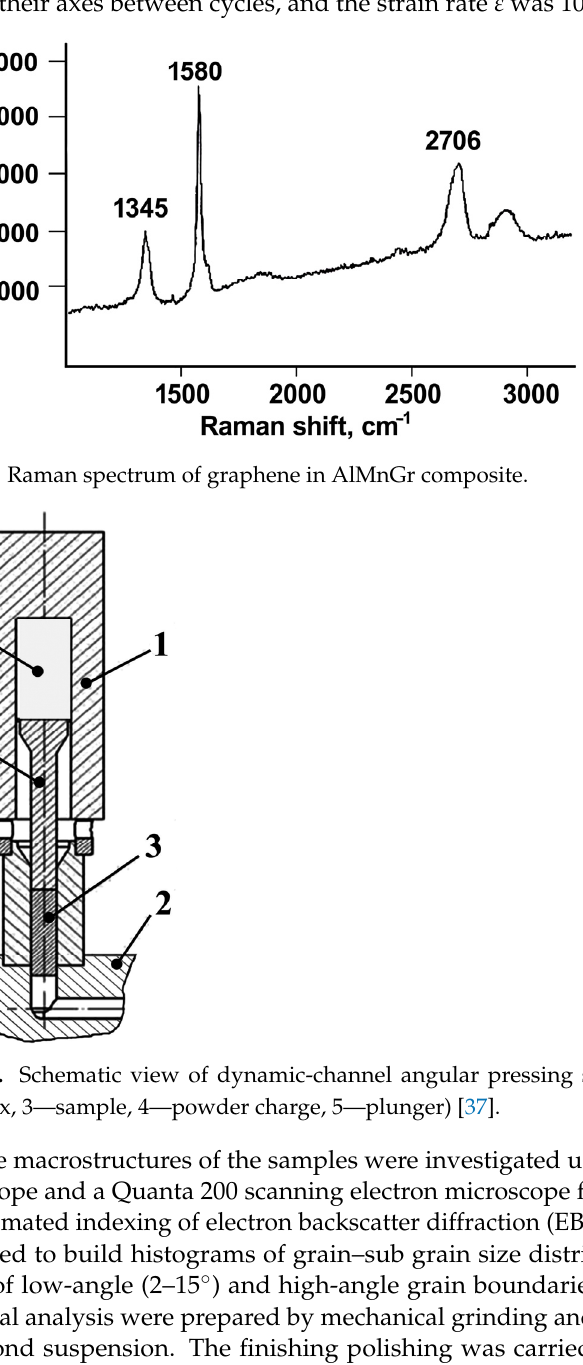
Figure 2. Schematic view of dynamic-channel angular pressing set up with plunger(1—barrel, 2— matrix, 3—sample, 4—powder charge, 5—plunger) [37].